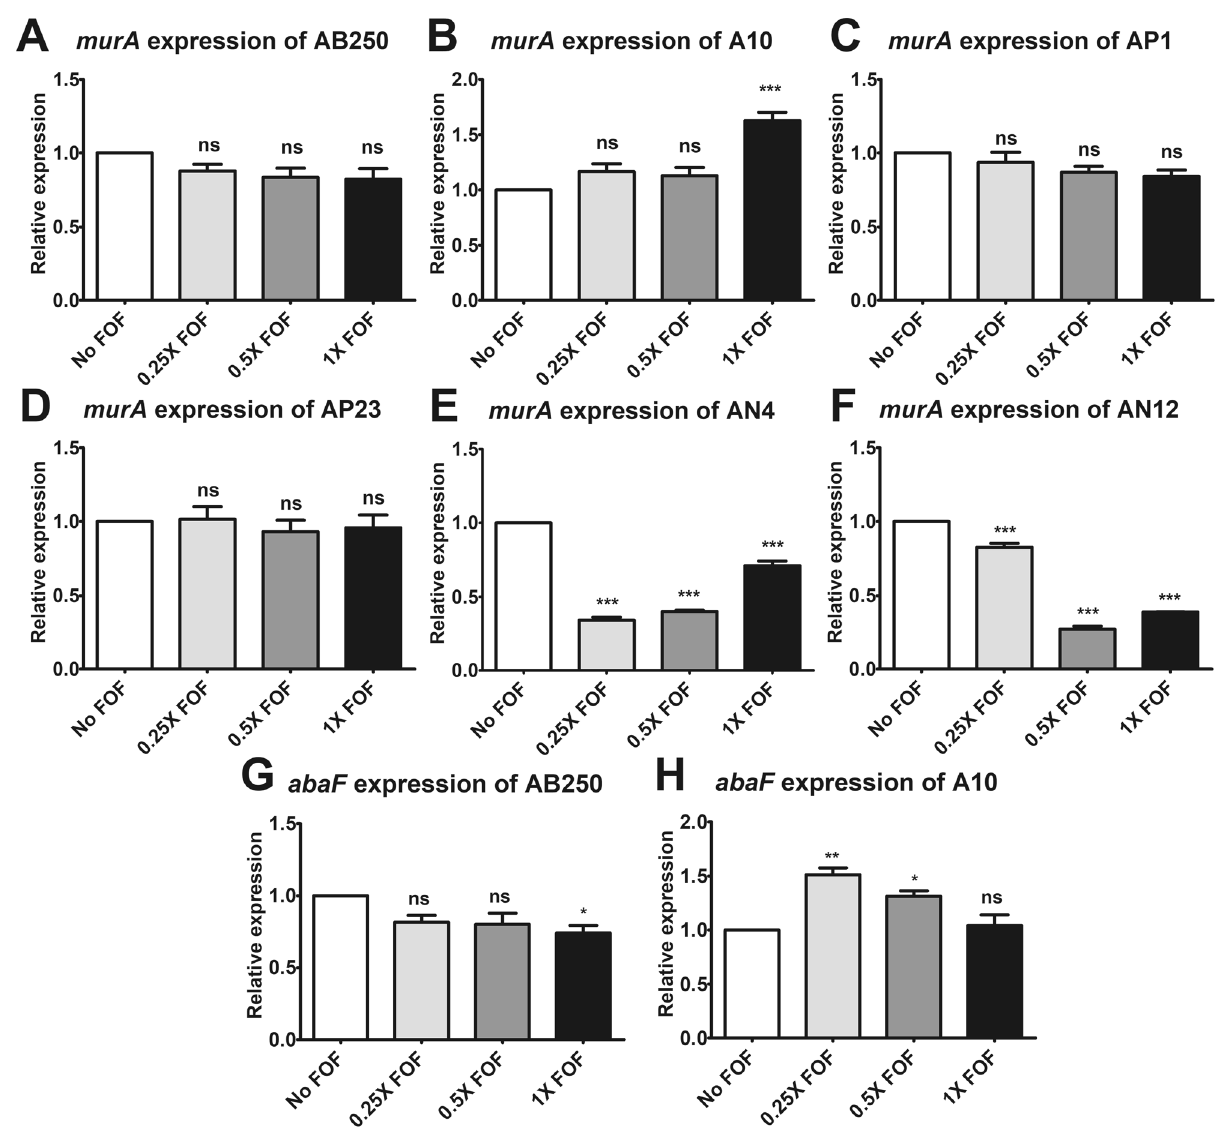
Figure 3. Relative mRNA expression of murA in six ACB isolates. RT-PCR assay of murA expression after 2 h of exposure to fosfomycin was determined in A. baumannii AB250 ( A ) and A10 ( B ), A. pittii AP1 ( C ) and AP23 ( D ), and A. nosocomialis AN4 ( E ) and AN12 ( F ). The relative mRNA expressions at each condition (in the presence of 0.25× MIC, 0.5× MIC, or 1× MIC of fosfomycin) were normalized to 16S rRNA expression and compared to the mRNA expression level of each isolate in the absence of fosfomycin. The relative mRNA expressions of abaF in A. baumannii AB250 ( G ) and A10 ( H ) at each condition (in the presence of 0.25× MIC, 0.5× MIC, or 1× MIC of fosfomycin) were normalized to 16S rRNA expression and compared to the mRNA expression level of each isolate in the absence of fosfomycin. All experiments were performed in triplicate. Mean values of the relative mRNA expression were plotted with error bars representing the standard error of the mean (n = 3). The p -values were calculated using one-way ANOVA, Dunnett’s multiple comparison test (* p -value ˂ 0.05; ** p -value < 0.01; *** p -value < 0.001 and ns, murU (Fig. 5C,D) and anmK (Fig. 5E,F) had either little or no expression in the presence of fosfomycin MIC, although viable cells of both isolates were above 10 6 CFU/mL at 12 h (Fig. 2B,E). To evaluate the role of imipenem combination on cell wall recycling, the expression of cell wall recycling was determined after 12 h exposure to 0.5× fosfomycin MIC with 1× imipenem MIC, which had synergistic activity in A10 (Fig. 2F) but not in AB250 (Fig. 2C), compare to either fosfomycin or imipenem alone. Imipenem in the combination did not affect murA expression in AB250 (Fig. 6A) but downregulated in A10 (Fig. 6B). The transporter gene, ampG , was upregulated in the imipenem combination in AB250 (Fig. 6C) but had no effect in A10 (Fig. 6D). In AB250, although imipenem combination induced murU expression, its expression level was slightly lower than that in the absence of imipenem (Fig. 6E). In contrast, the combination reduced murU expression in A10 nearly to that in the absence of any antibiotic (Fig. 6F). Interestingly, imipenem combination